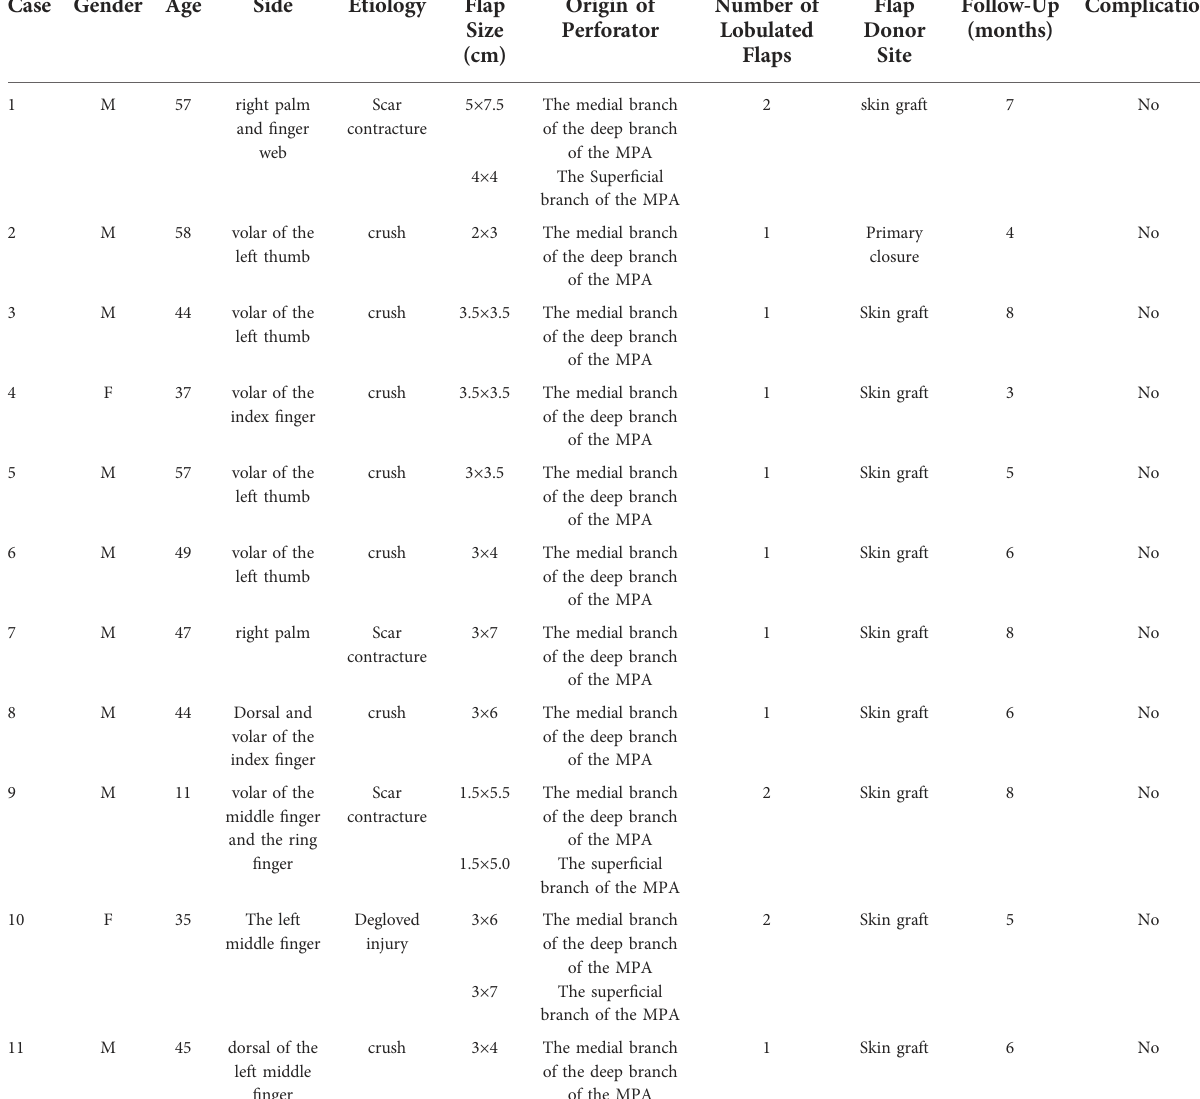
TABLE 1 Summary of the patients receiving MPAP fl ap. Case Gender